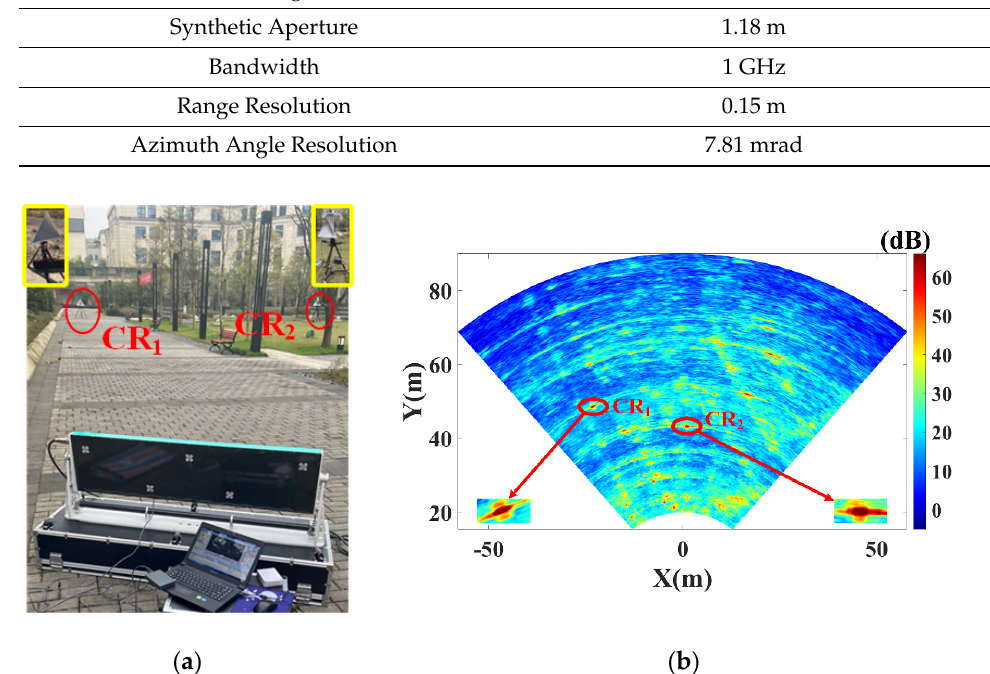
Figure 7. ( a ) Experimental scenario; ( b ) Signal-to-noise (SNR) map.